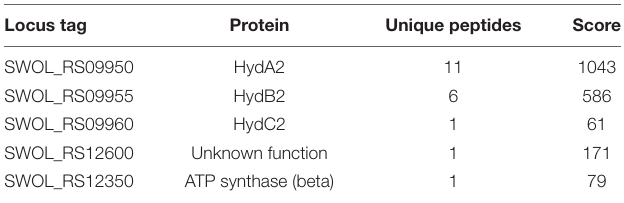
TABLE 2 | Proteins detected in a membrane complex testing positive for hydrogenase activity in membrane fractions of S. wolfei grown on butyrate a .